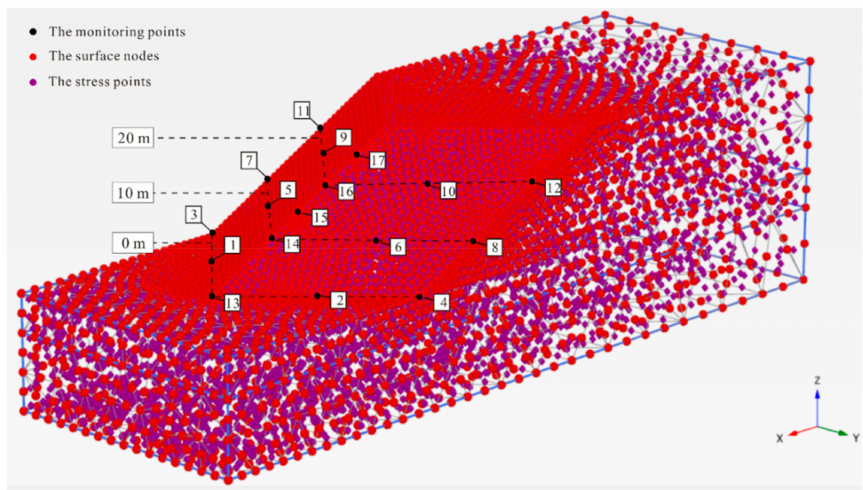
Figure 13. Distribution of nodes and stress points in the calculating model: an example using a slope with a turning corner of 90 ◦ and gradient of 1:2.